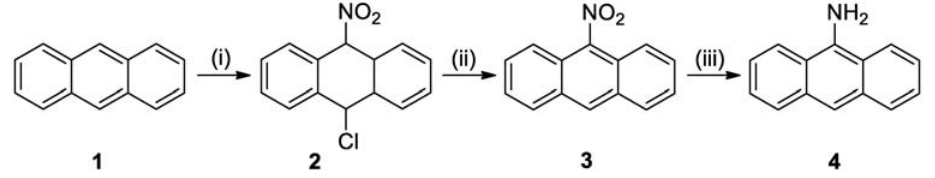
Scheme 2. Schematic illustration of 9-aminoanthracene synthesis. Reagents and conditions: (i) concd. HNO 60–70 °C; (iii)